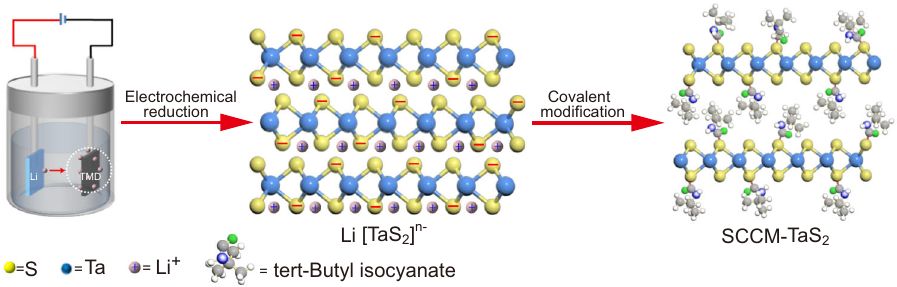
Fig. 1 | Schematic of synthesis processes of SCCM-TaS 2 . Schematic of the electrochemical reaction and side chains covalent modi fi cation for SCCM-TaS 2 organic/ inorganic hybrid structure.